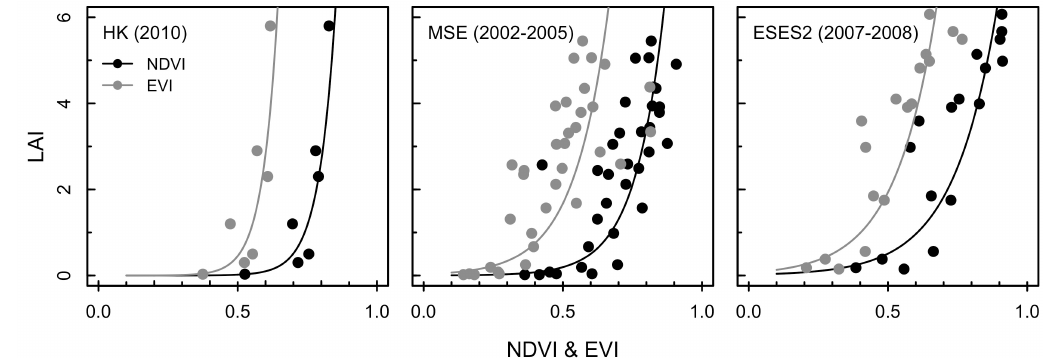
Figure 2. The relationships between LAI and NDVI (black closed circles with solid line) and between LAI and EVI (gray closed circles with solid line) using the data from the entire growing season. HK = Haean (S. Korea), MSE = Mase (Japan), and ESES2 = El Saler-Sueca